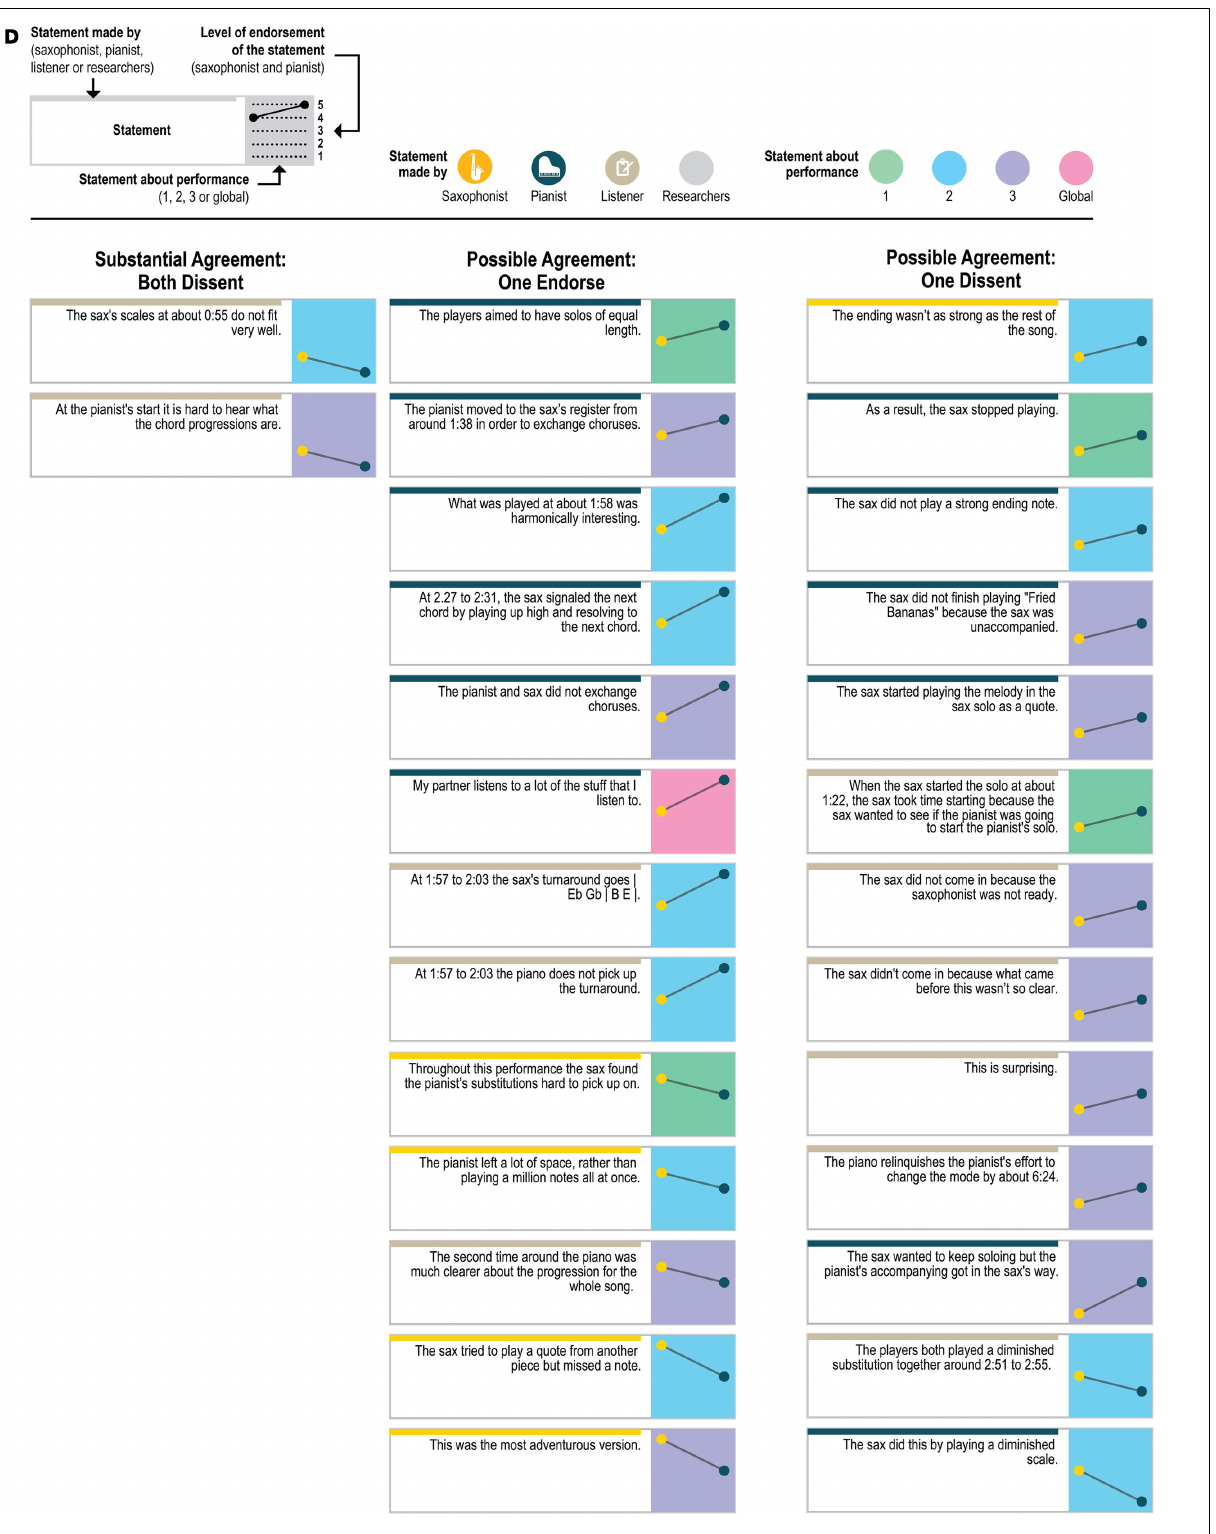
FIGURE 5D | Statements with substantial agreement (ratings different by only 1 point) where both players dissented, and statements with possible agreement (one player’s rating was neutral and the other’s was not).